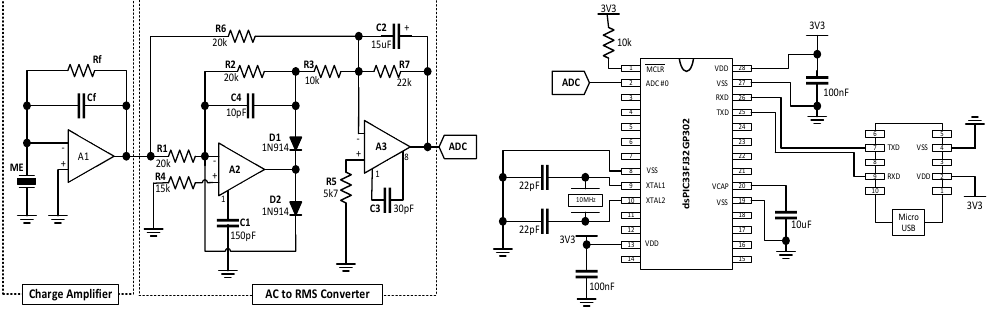
Figure 5. ( left ) ME signal modulation circuit with two distinct stages: charge amplification resulting in an AC voltage output signal and AC-to-DC voltage converter. ( right ) Analog-to-digital converter circuit to which the previous analogue circuit was connected.